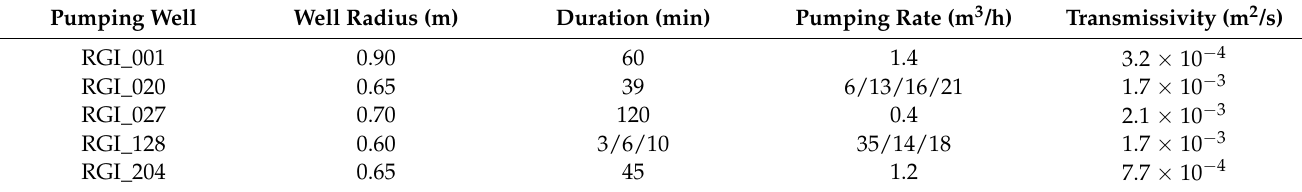
Table 1. Characteristics of the pumping tests and obtained